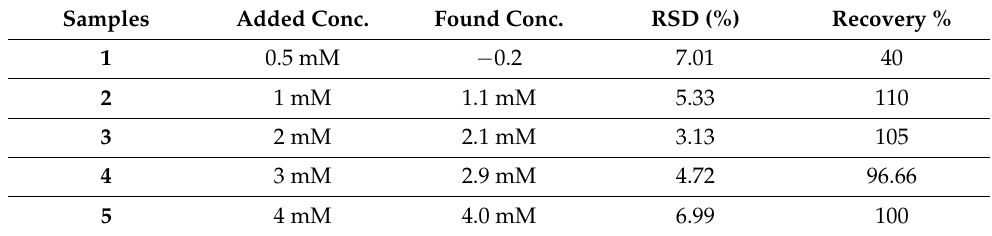
Table 2. Determination and recovery of glucose in spiked blood samples, using SPCE/CuS-2 sensor. Samples Added Conc. Found Conc.